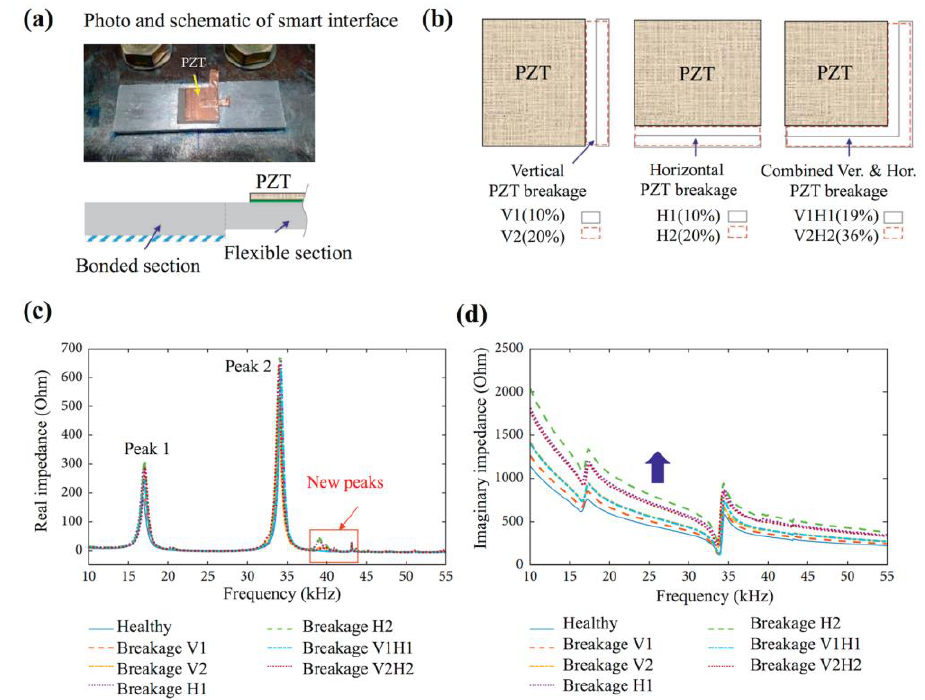
Figure 6. ( a ) Photo and schematic of smart interface with PZT transducer; ( b ) schematic of PZT breakage; ( c , d ) numerical EMI responses under PZT debonding defects, PZT breakage, and interface debonding defect [76].